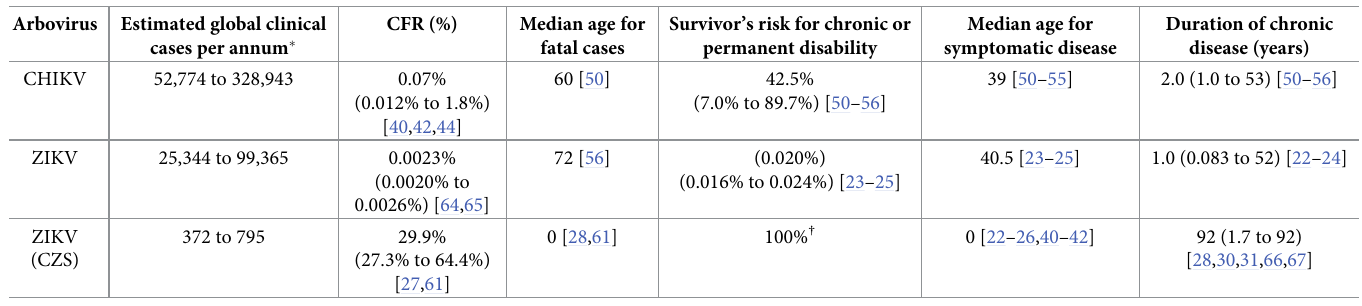
Table 2. Extracted data used for DALY